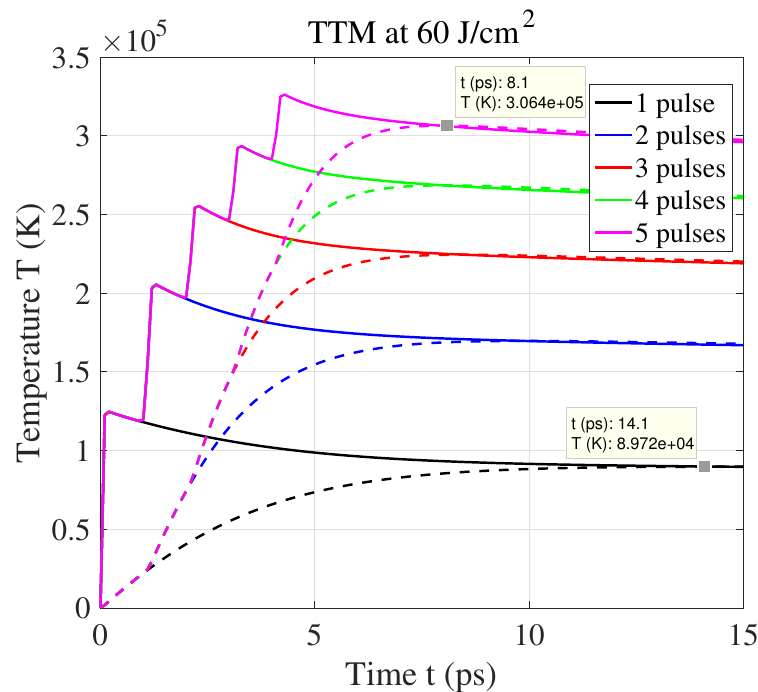
Figure 3. Time dependence of the calculated electron (solid line) and lattice (dash line) temperature with varying pulse number at a fluence of 60 J/cm 2 and 1 ps (1 THz) of separation time (repetition